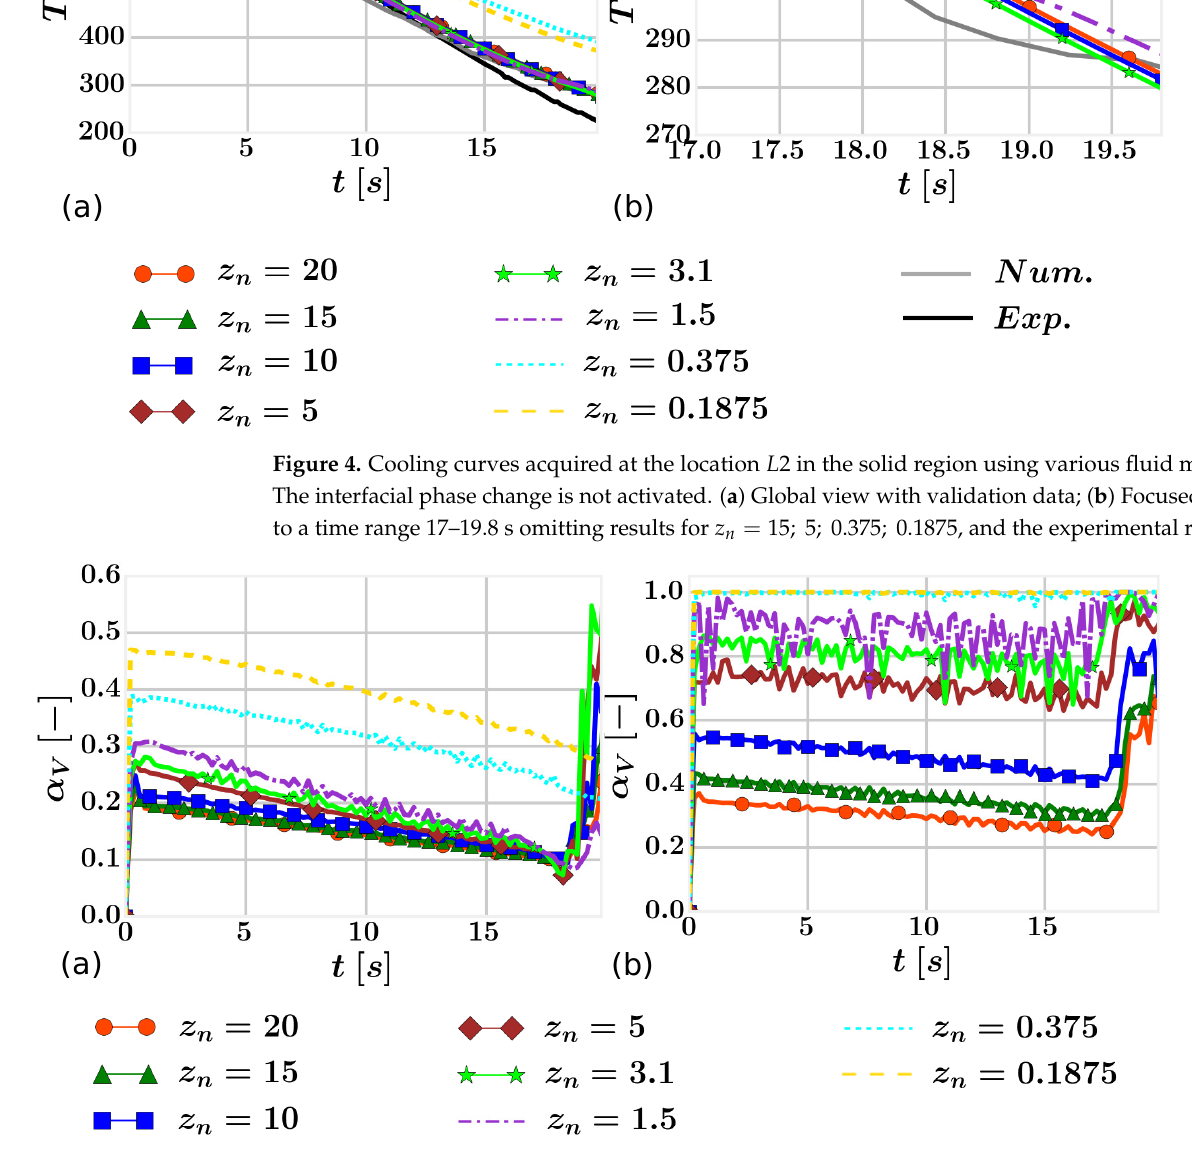
Figure 5. Vapour volume fraction using various fluid meshes. The interfacial phase change is not activated. ( a ) Location L 1; ( b ) Location L